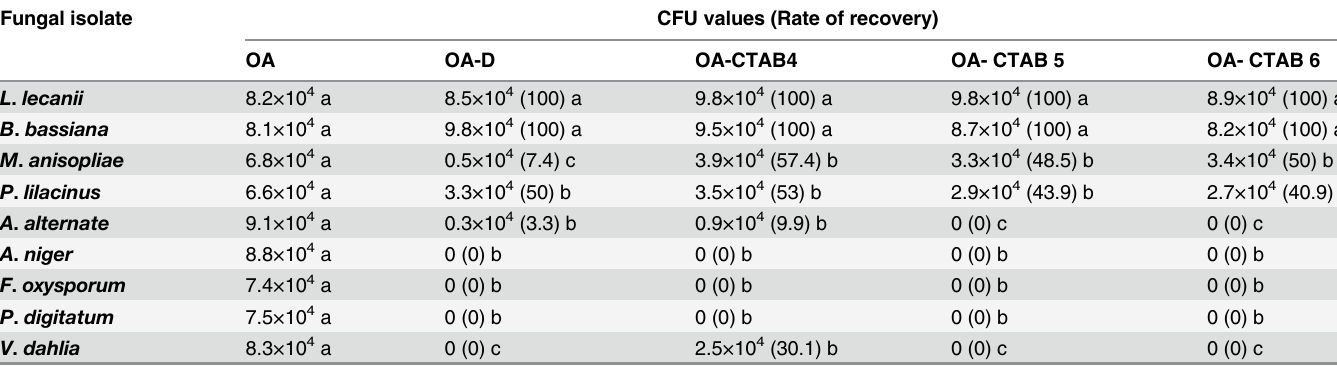
Table 2. Detection of different fungi on the culture media tested a . Fungal